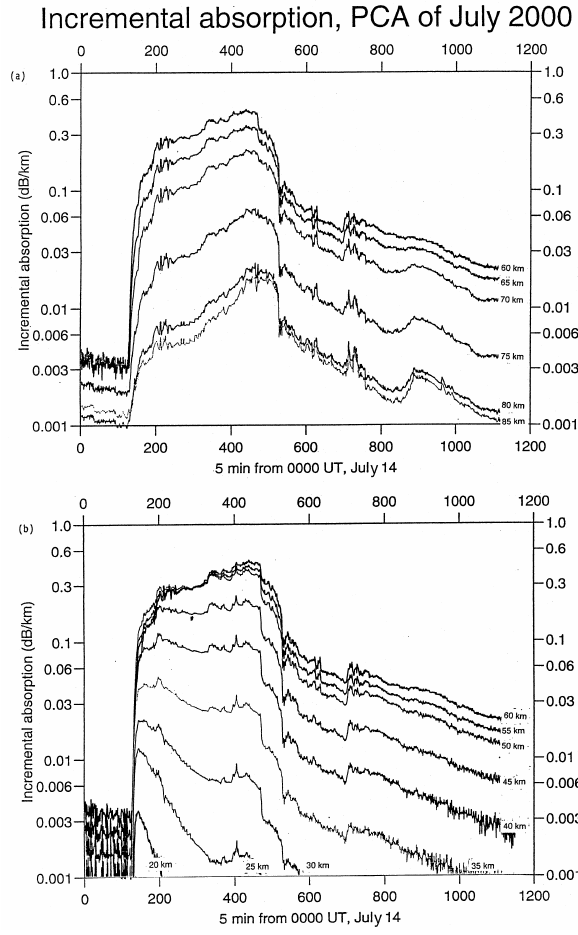
Fig. 10. The incremental absorption (dB/km) at heights 20 to 85km, during the PCA of July 2000, showing the contribution maximising at 50–65km during most of the event.